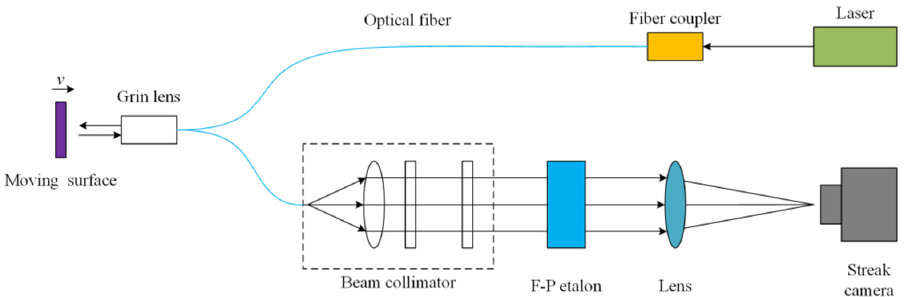
Figure 13. The main parts of FPI system.